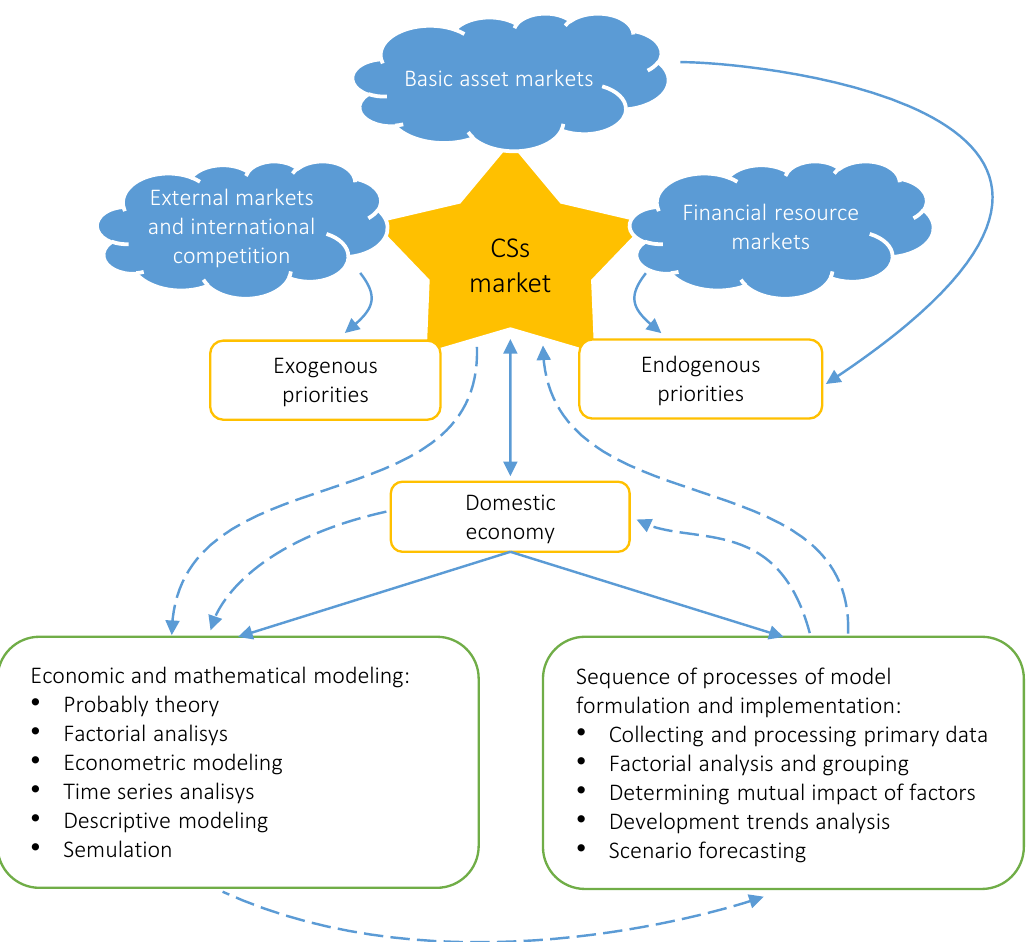
Domestic economy